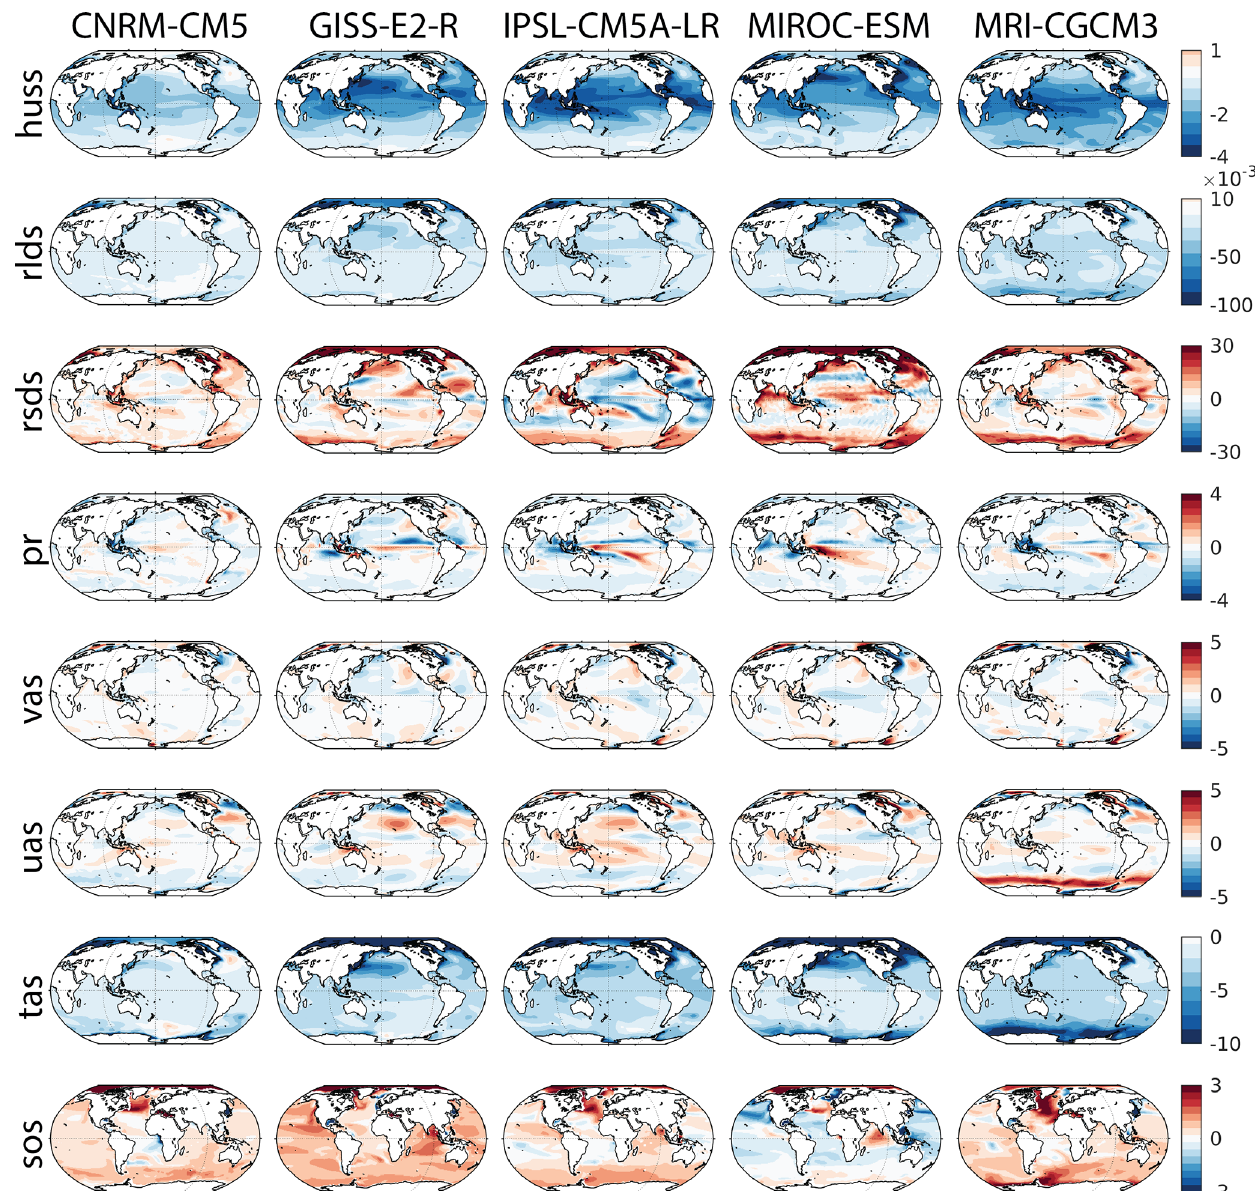
Figure A1. Annual mean individual model anomalies for each of the variables (see Table 1) and models in the dataset. Units are the same as in the remainder of this